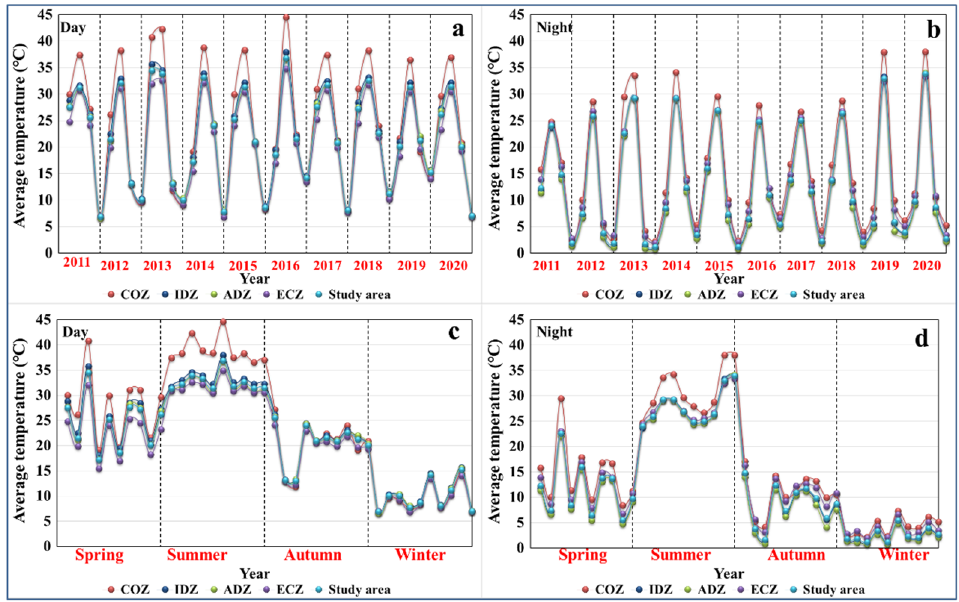
Figure 7. The average LST of MFOZ from 2011 to 2020 (( a , b ) are the average temperature of MFOZ during daytime and nighttime in different years, respectively; ( c , d ) are the average temperature of MFOZ during daytime and nighttime in different seasons, respectively).